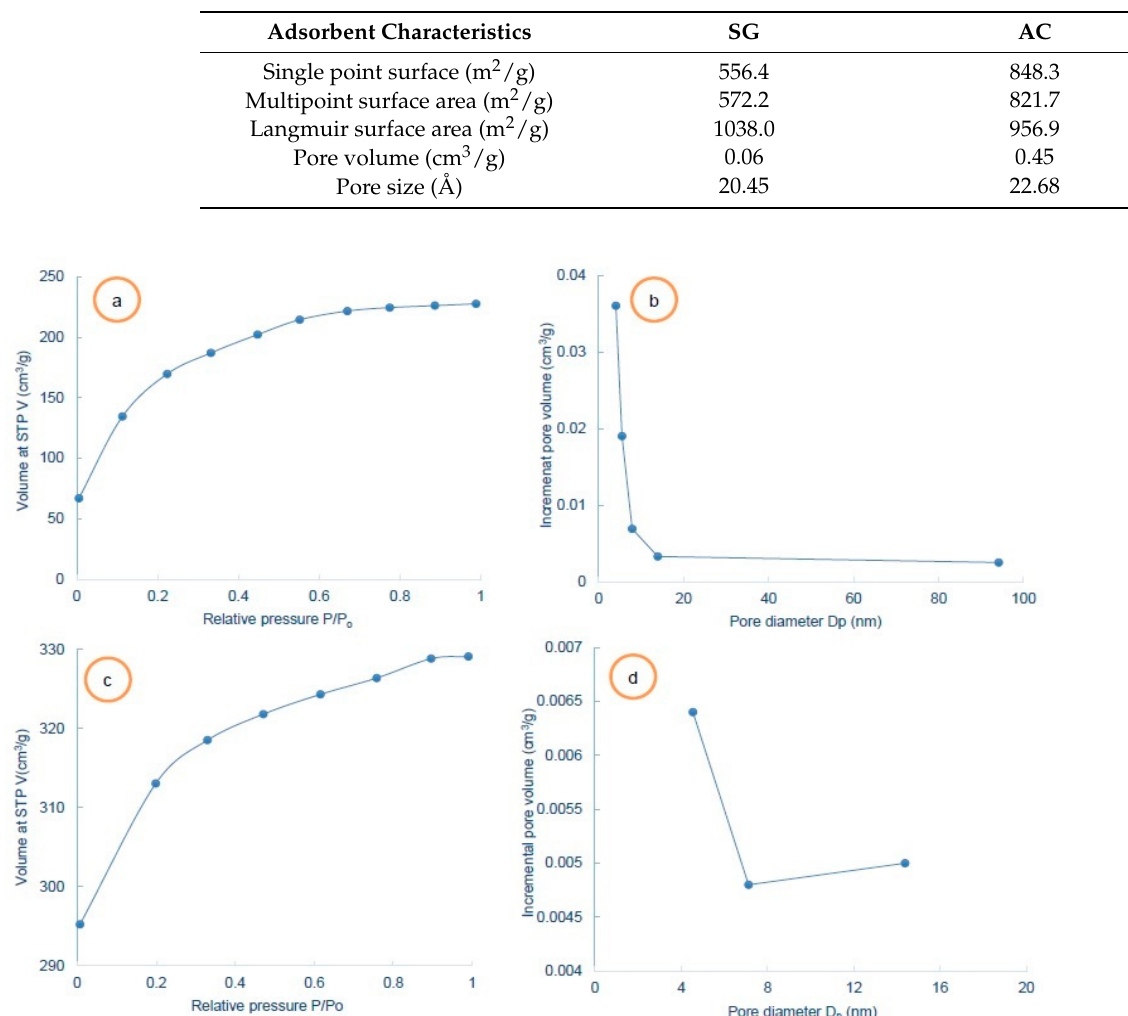
Table 2. BET Surface characterizations of SG and AC.